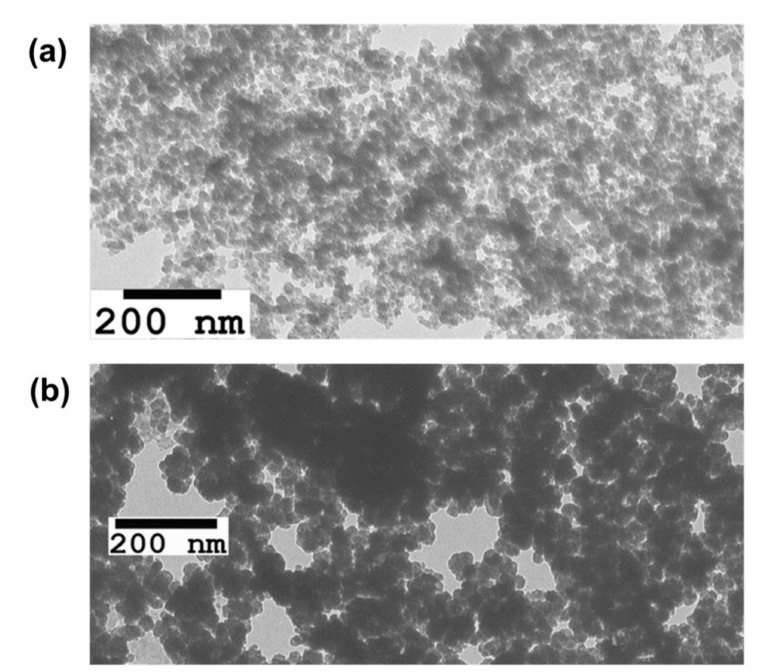
Figure 2. TEM images of precursor nanomaterials: ( a ) SNP; ( b ) MNP. For covalent immobilization of quinacrine, the surfaces of nanoparticles were modified with (3-glycidyloxypropyl)trimethoxysilane according to the diagram shown in Figure 3.